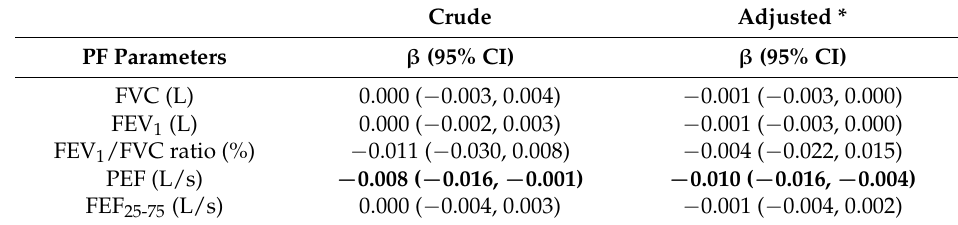
Table 4. Association of serum 25(OH)D concentration (nmol/L) with pulmonary function (PF) parameters. Crude Adjusted * PF Parameters β (95% CI)